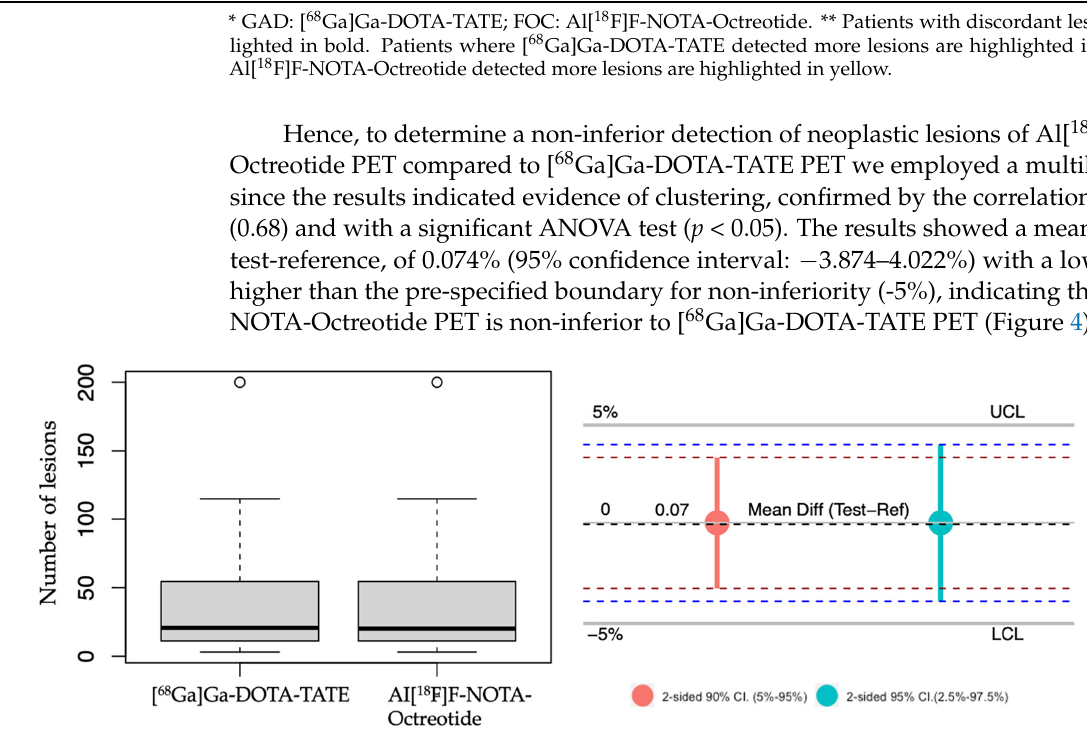
Figure 4. Non-inferiority analysis. Left panel, boxplot representing the average of tumoral lesions detected with [ 68 Ga]Ga-DOTA-TATE and Al[ 18 F]F-NOTA-Octreotide. right panel, a non-inferiority chart 2-sided 90% confidence interval (red) and 95% confidence interval (light blue). UCL: upper clinically significant margin limit 5%. LCL: lower clinically significant margin limit of 5%. The mean difference is indicated. Outliers are represented as circles.